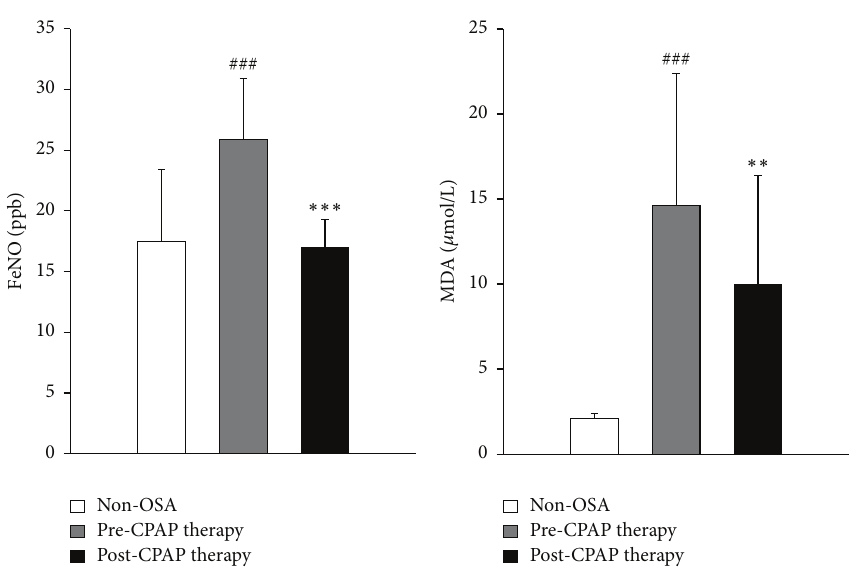
Figure 3: Effect of continuous positive airway pressure (CPAP) therapy on fractional exhaled nitric oxide (FeNO) and malondialdehyde (MDA) levels in 13 obstructive sleep apnea (OSA) patients and 13 non-OSA controls. ∗∗ 𝑃 < 0.01 and ∗∗∗ 𝑃 < 0.001 pre- versus post-CPAP therapy, ### 𝑃 < 0.001 non-OSA versus pre-OSA